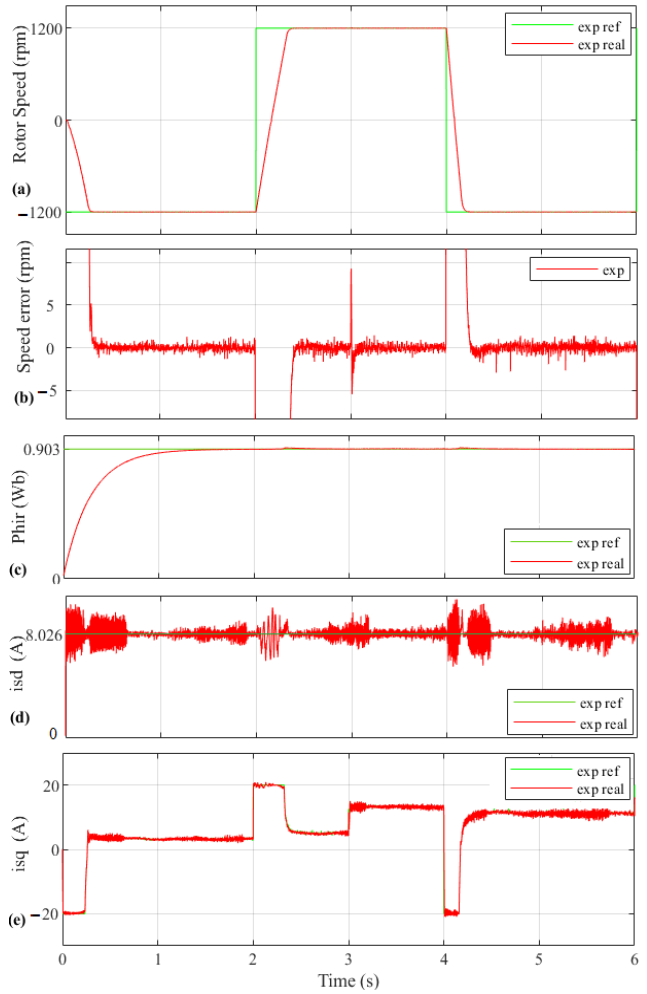
Figure 12. Experimental results with 1200-rpm reference speed and two load torque step changes, with 60% higher uncertainty in σ L s (enhanced ISMC D2 design T3 tuning): ( a ) Rotor speed, ( b ) Speed error, ( c ) Rotor flux, ( d ) Rotor flux current and ( e ) Torque